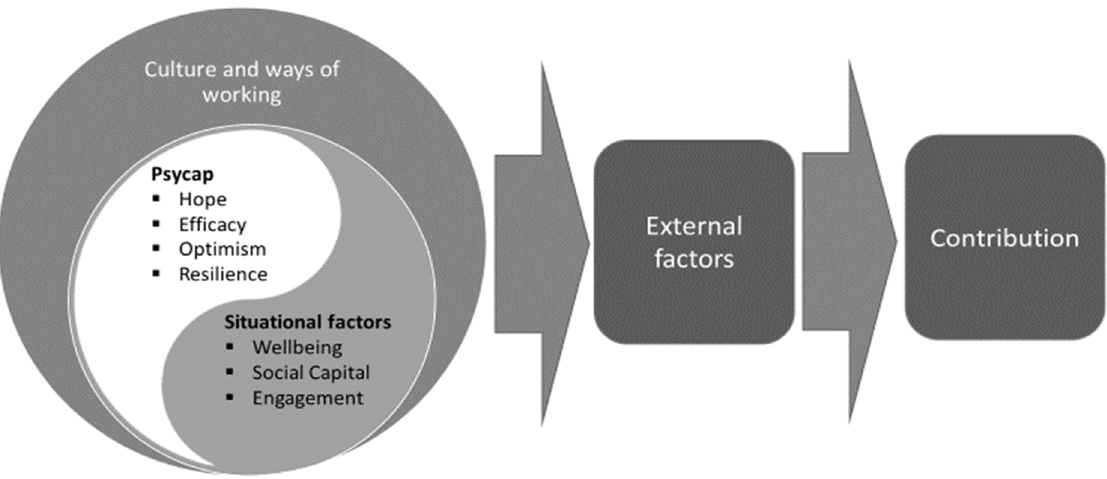
Figure 1. Proposed model.